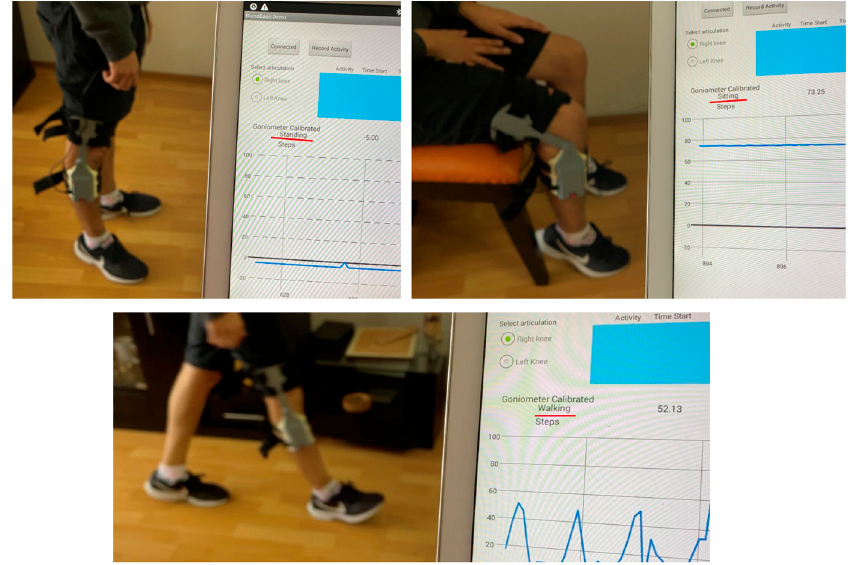
Figure 9. Results of the algorithm in real-time testing, and the activity shown by the app is underlined with red. Top left : Standing. Top right : sitting. Bottom : walking.